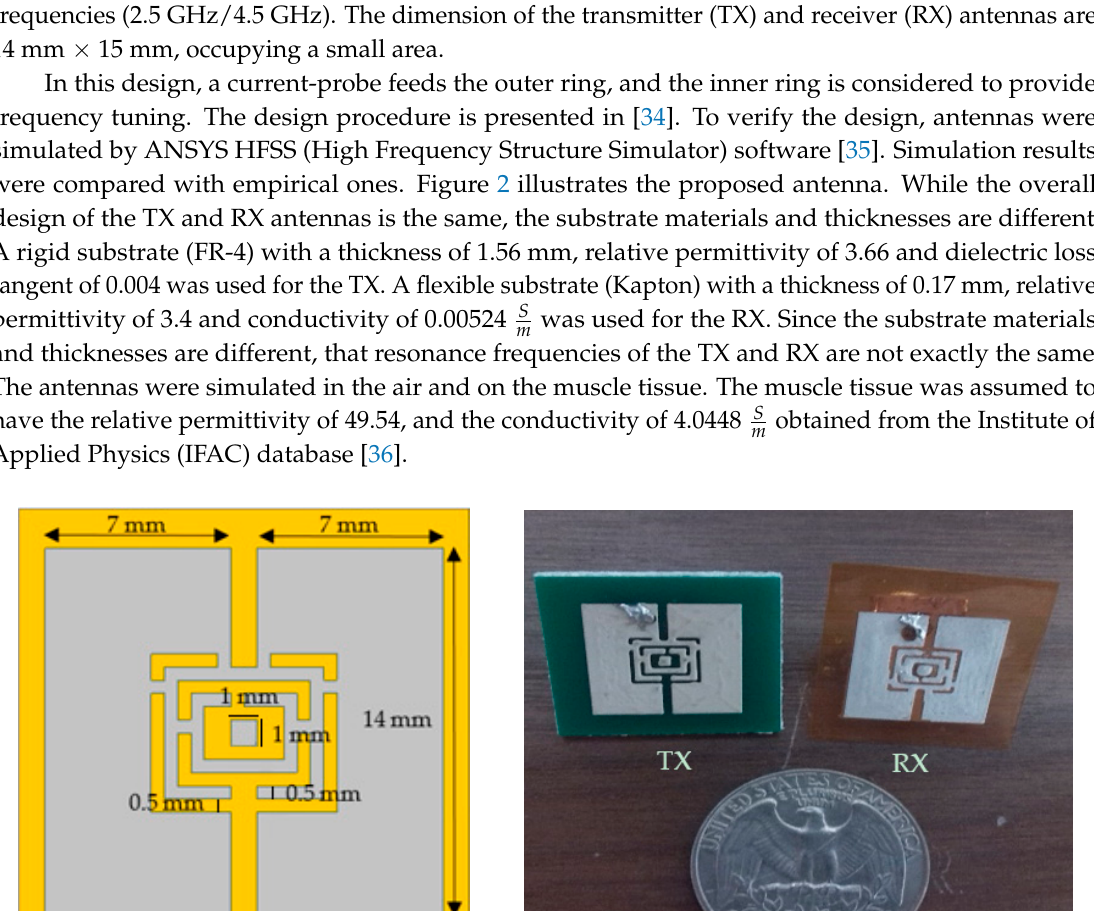
Figure 2. Transmitter (TX) and receiver (RX) antennas ( a ) antenna structure parameters, ( b ) TX and RX fabricated prototypes.